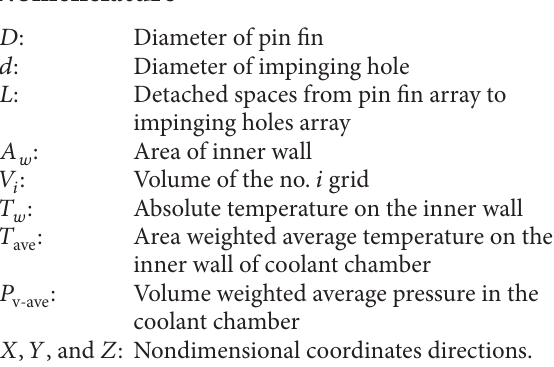
Figure 8: Comparison of the 𝑇 without